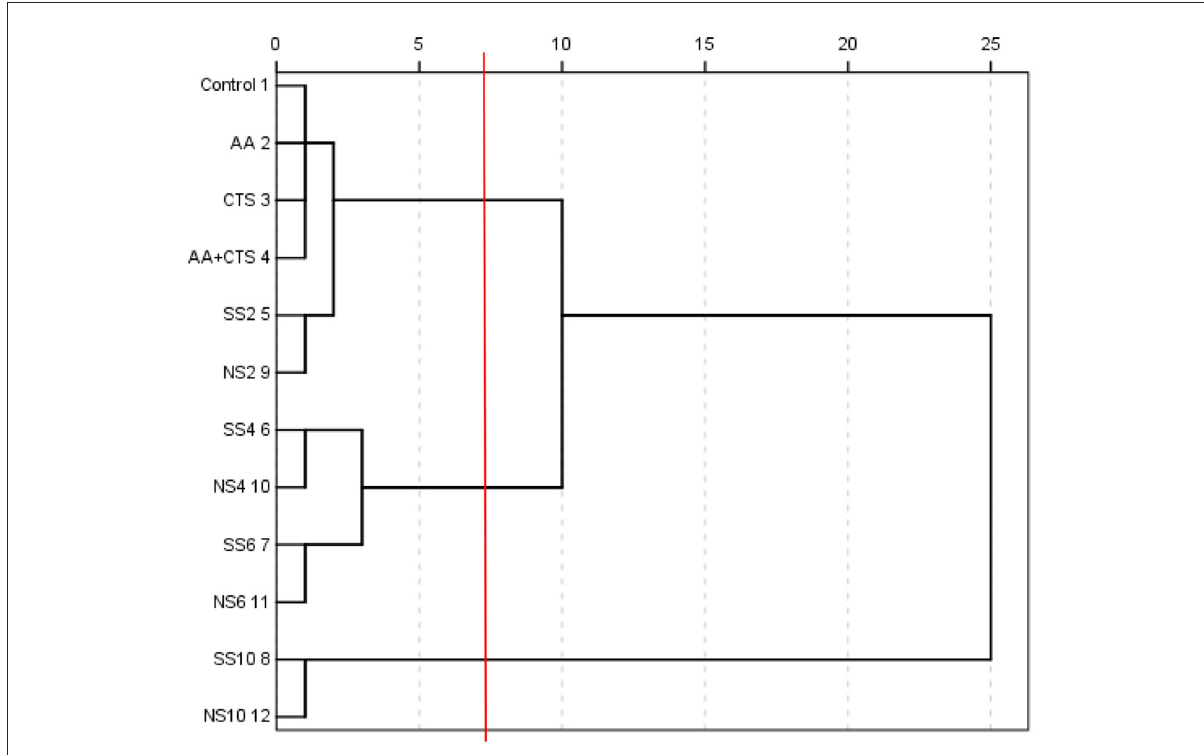
FIGURE3 Result of cluster analysis of soy